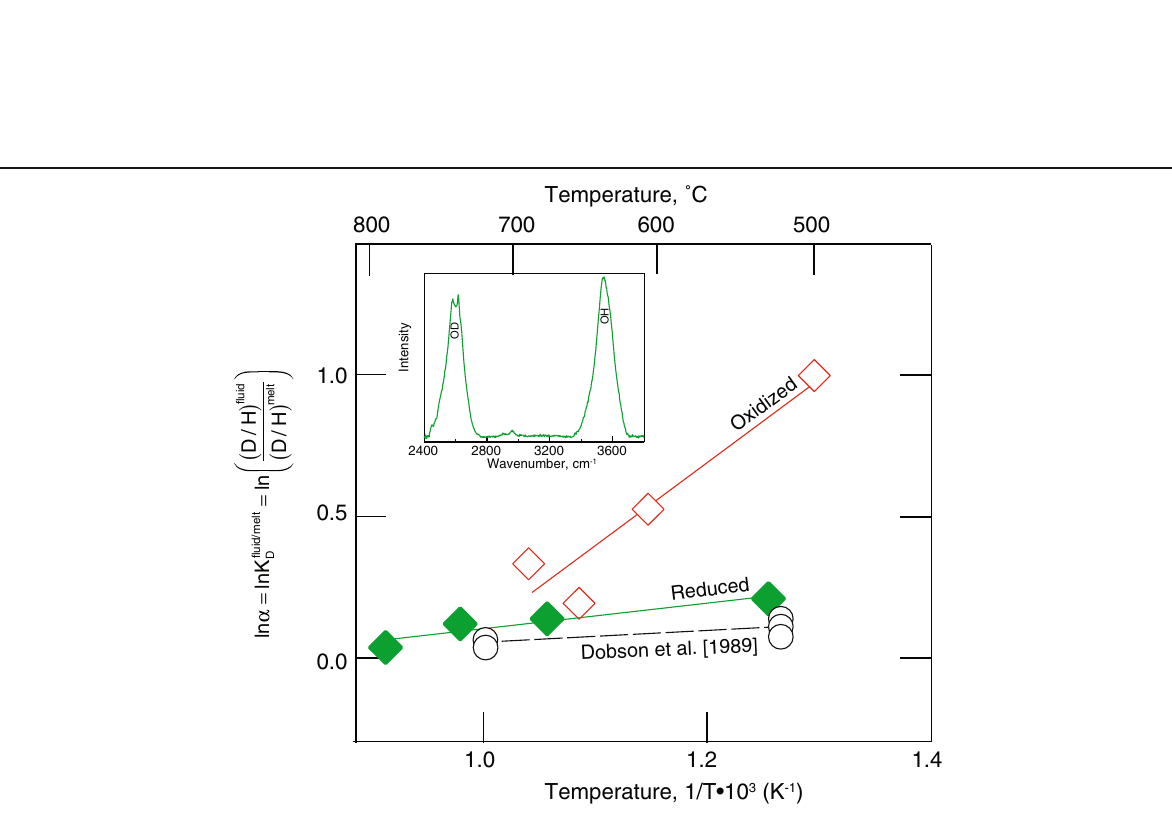
Fig. 6 Fractionation factor, α , set equal to the fluid/melt exchange equilibrium coefficient (see text for discussion) for D/H exchange between coexisting fluid and melt as a function of temperature in silicate – COH systems under reducing and oxidizing conditions. Insert shows typical Raman spectrum (here from fluid) to illustrate the appearance of the Raman bands assigned to OD and OH stretch vibrations and used to extract the data themselves. The Δ H values from the two fits are given in Table 1. Also shown are the experimental data for rhyolite – H 2 O and feldspar – D 2 O glass and melt composition in the 5 – 20 MPa pressure range from Dobson et al. (1989) (data otherwise from Mysen